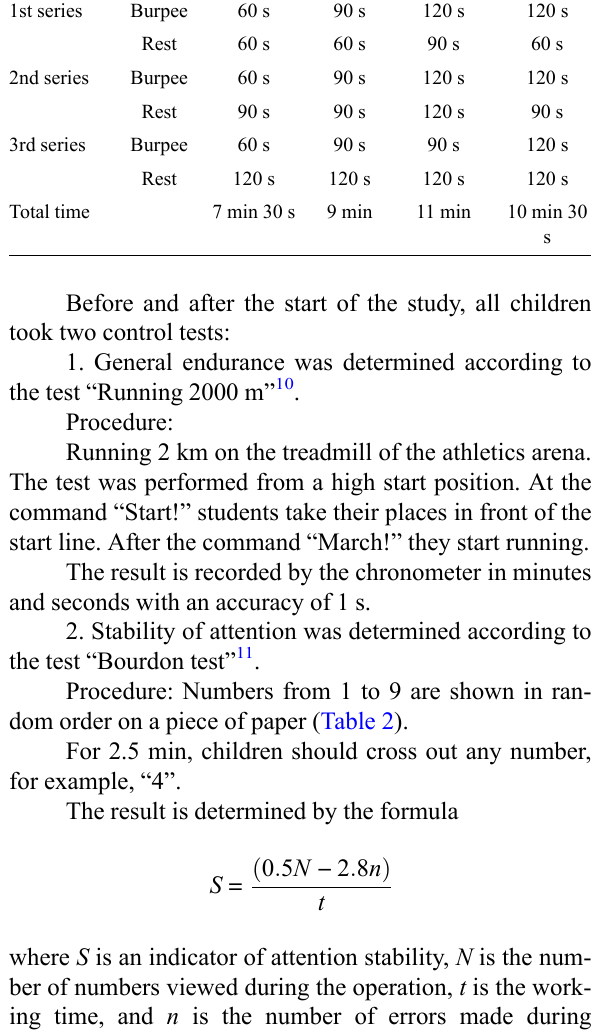
Table 1 - Components of physical activity exercise « Burpee » for chil- dren 15-16 years old. Number of series